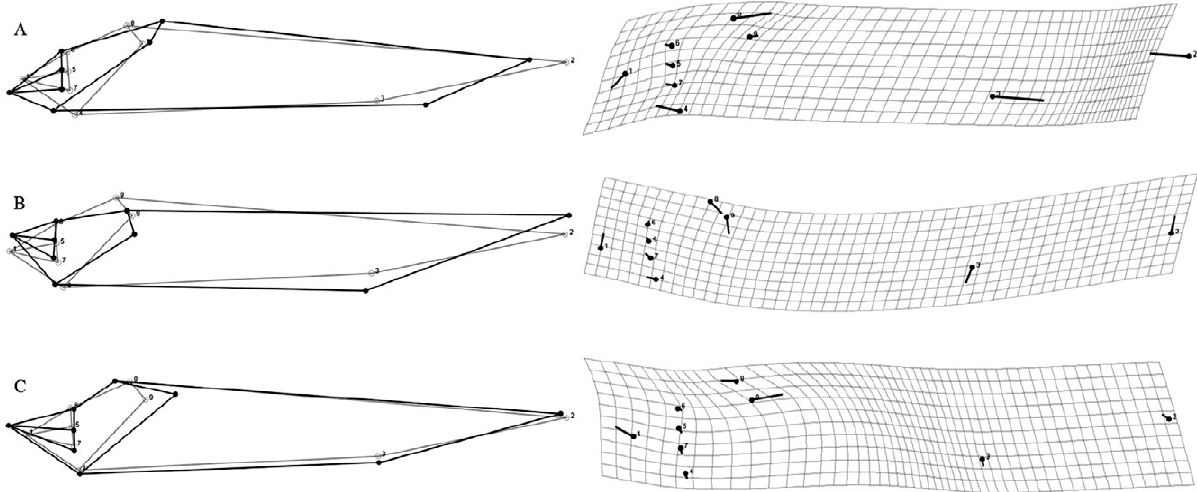
Fig. 3. – Morphometric change visualization in the three first principal components: (A) wireframe and transformation grid of PC1; (B) wireframe and transformation grid of PC2; C, wireframe and transformation grid of PC3. The wireframes and the grids refer to shape changes from negative to positive values along PC axis.